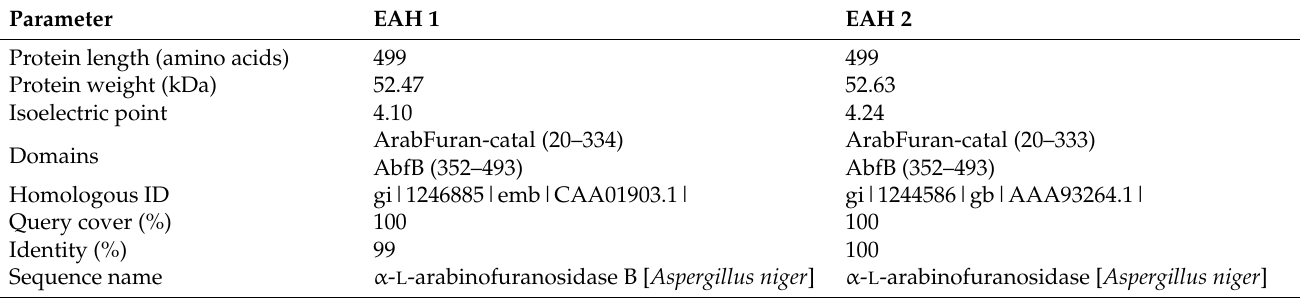
Table 3. Characteristics of EAH 1 and EAH 2